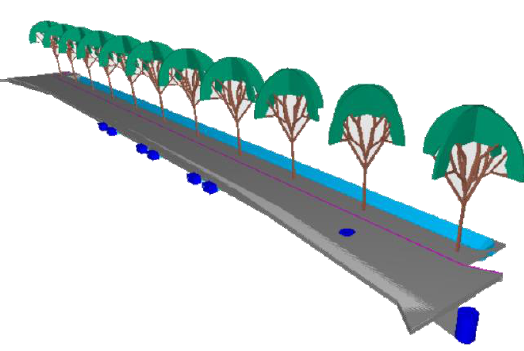
Figure 5. The As-Built BIM of the test site in Mariakerke